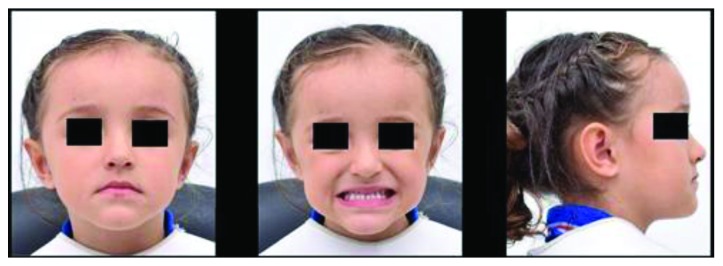
Extraoral photos.